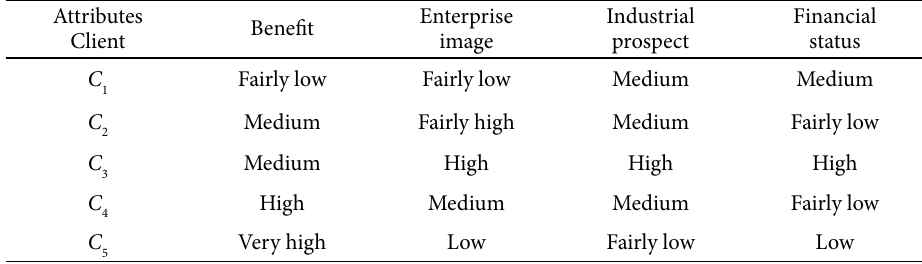
Table 6. Linguistic values of the score for client acceptance evaluation items from DM#3 Attributes